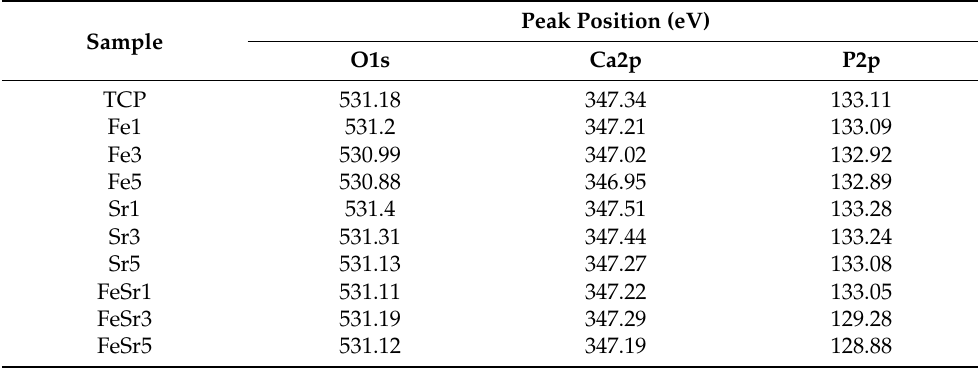
Figure 8. XPS spectra showing Fe2p, Sr3d, and Sr2p peaks of various β -TCP powders: ( a ) Fe- substituted samples, ( b ) Sr-substituted samples, ( c ) Fe/Sr co-substituted samples. Table 3. XPS peak position of various β -TCP powders.